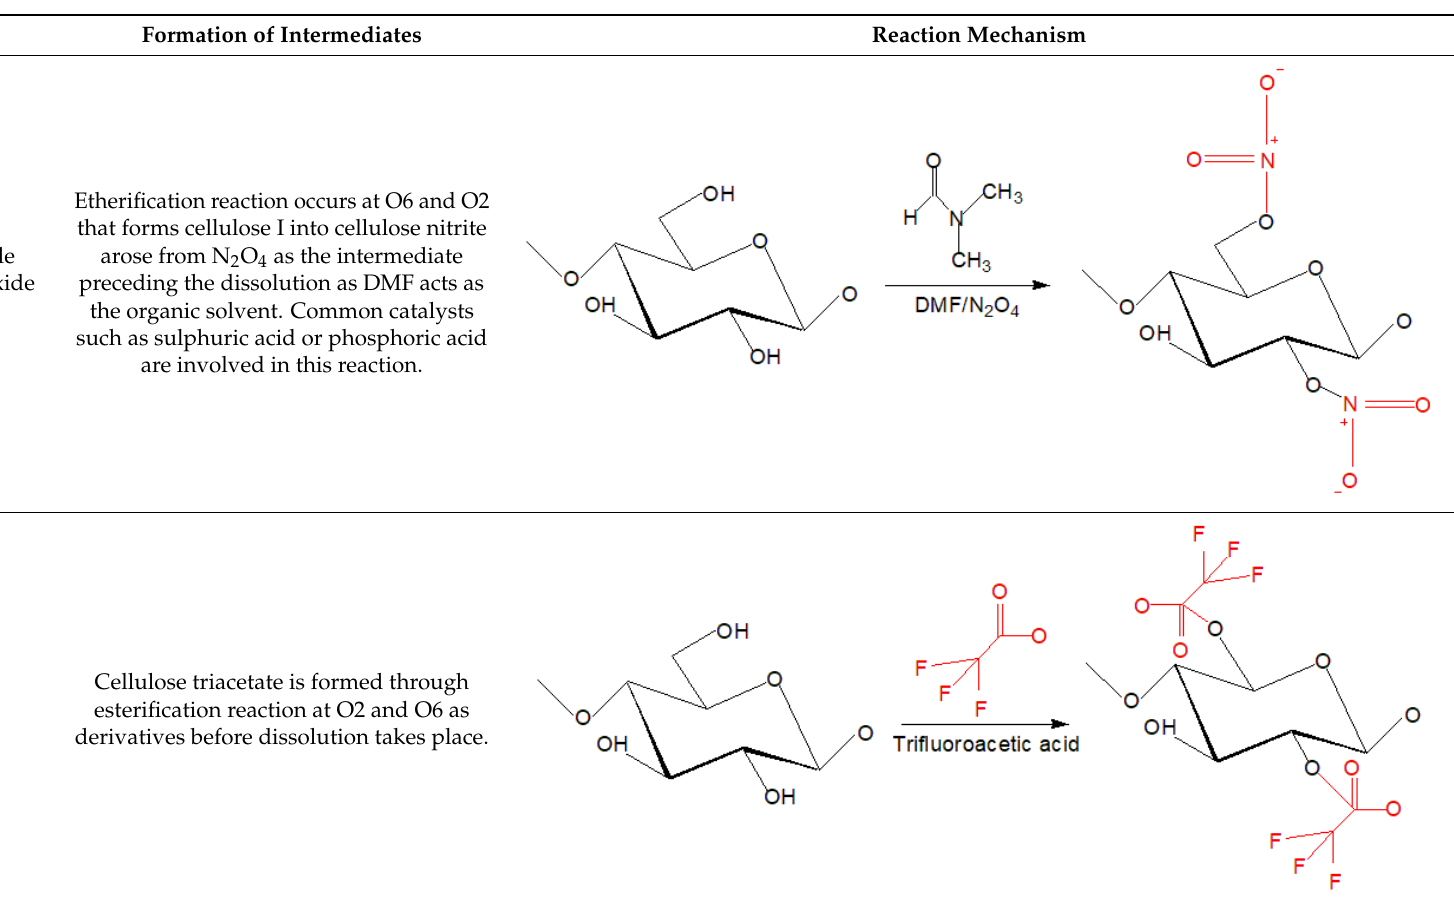
Table 1. Cellulose solvents and their action mechanism.